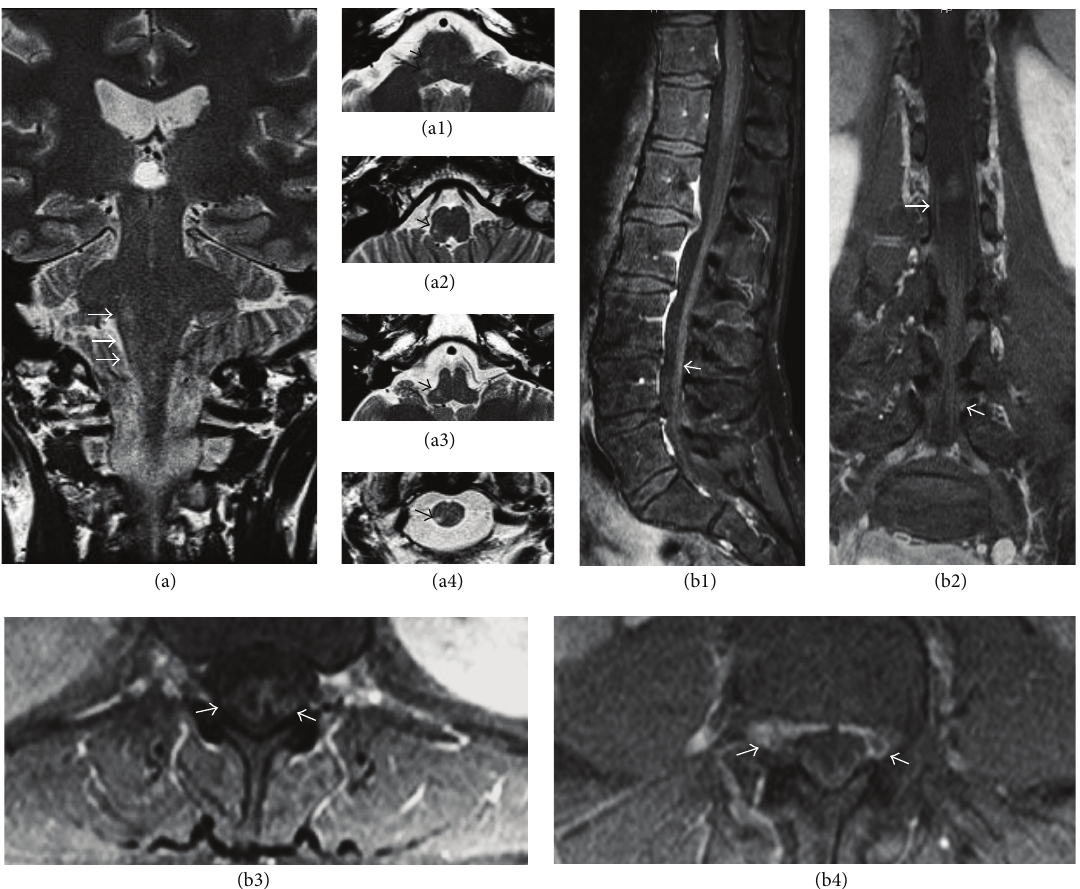
Figure 1: (a) Coronal and axial MRI sections of the brainstem to spinal cord showed small hypersignal-T2 in the right dorsolateral mid-pons (a1) and from the right dorsolateral aspect of the pontomedullary region (a2) to the right dorsolateral aspect of the upper cervical cord (a3-a4), along the course of the principle sensory nucleus and spinal nucleus of the right trigeminal nerve. Sagittal (b1), coronal (b2), and axial (b3-b4) spinal MRI showed enhancement of the nerve roots along the spinal